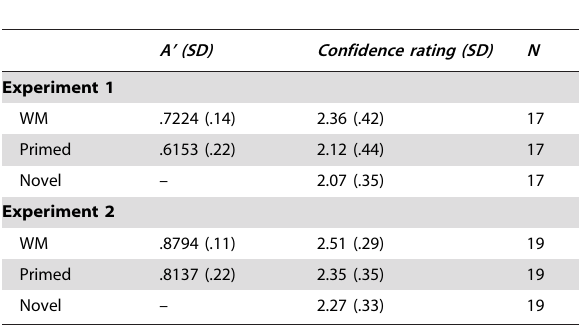
Table 3. Sensitivity (A’) and confidence ratings from Experiment 1 and Experiment